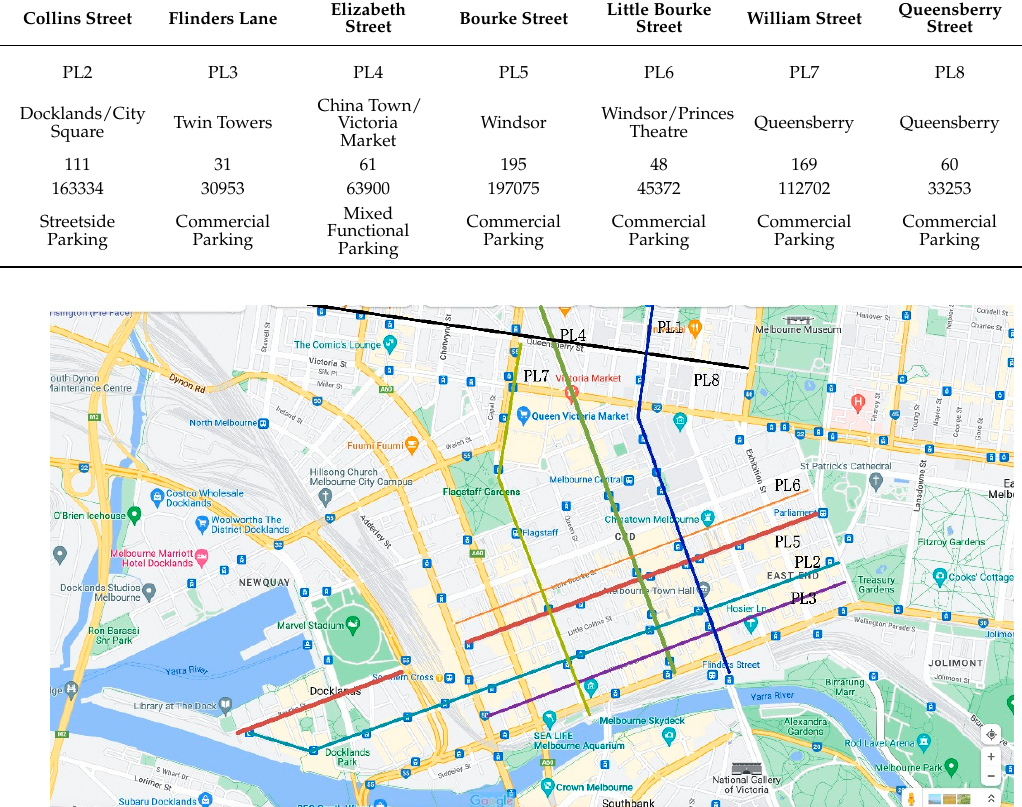
Figure 4. Map of Melbourne. Figure 4. Map of Table 2. Formats of parking data sets.